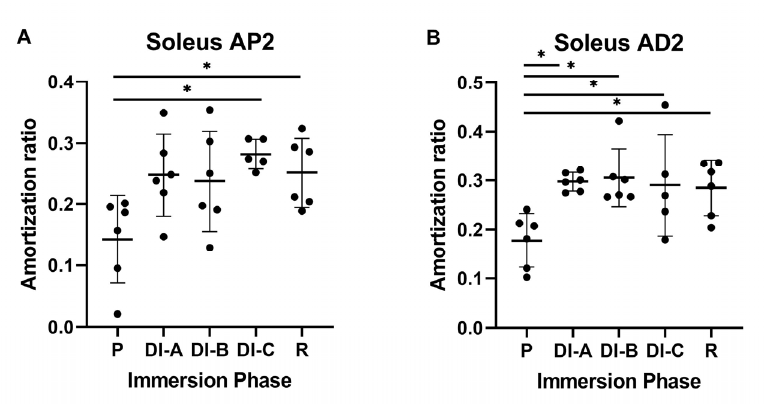
( p < 0.05): DI-C = 0.282 ± 0.02 and R = 0.251 ± 0.05.